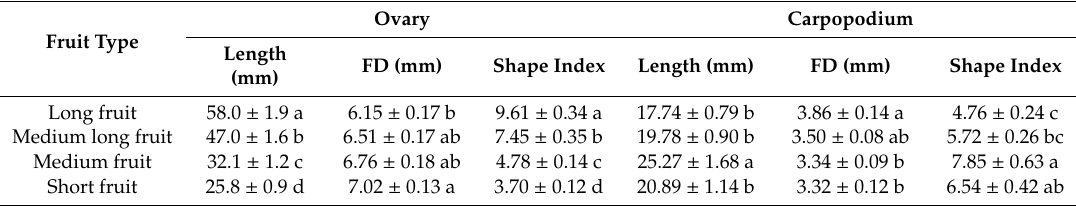
Table 6. The shape traits of ovary and its carpopodium of four types of cucumber